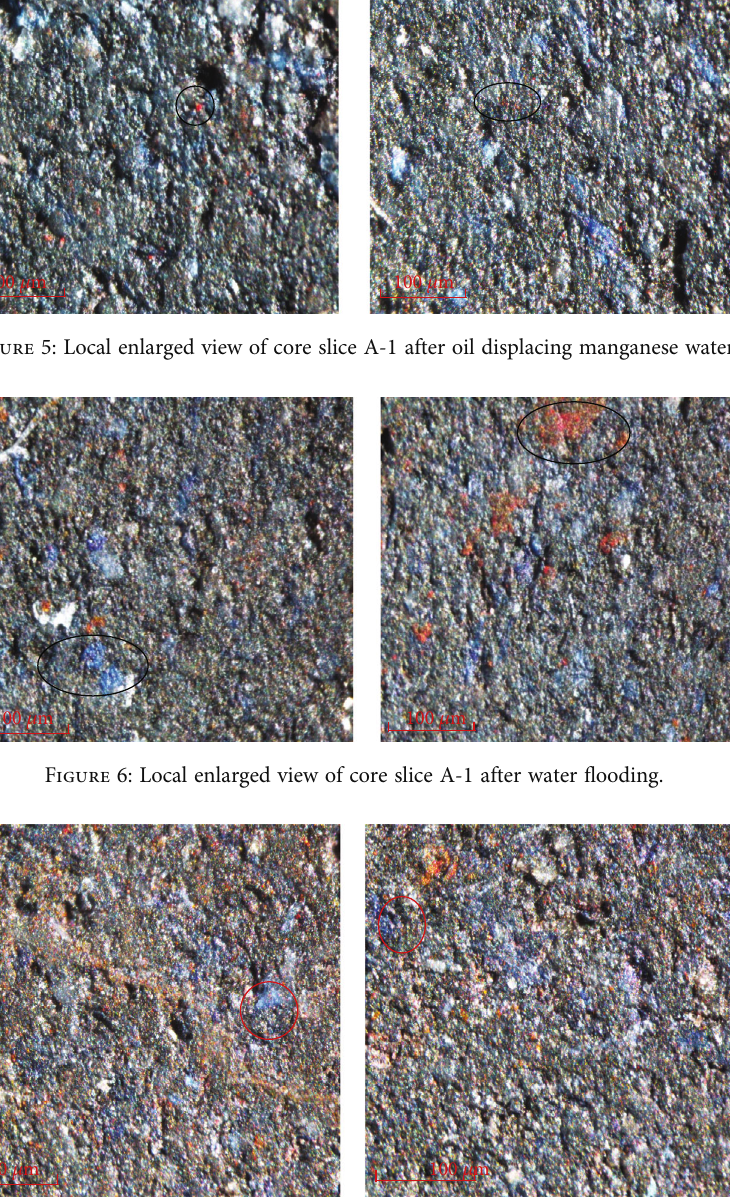
Figure 7: Local enlarged view of core slice A-1 after oil reverse